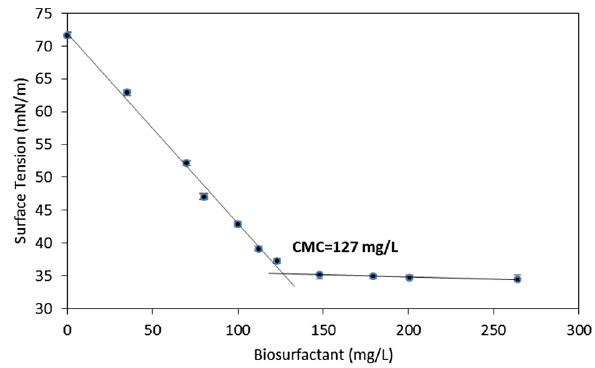
Fig. 2 Determination of the critical micellar